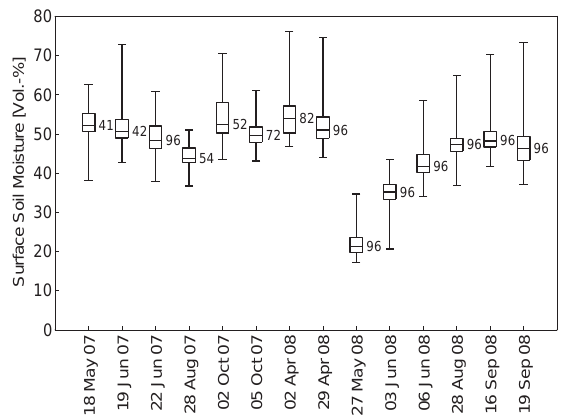
Figure 2. Box-Whisker-Plot for the grassland site of all days of surface soil moisture Fig. 2. Box-Whisker-Plot for the grassland site of all days of surface measurements; the bottom and top of the box show the lower and upper quartiles, the band soil moisture measurements; the bottom and top of the box show the near the middle of the box is the median, the ends of the whiskers represent the measured lower and upper quartiles, the band near the middle of the box is the minimum and maximum surface soil moisture; the number to the right of each box indicates median, the ends of the whiskers represent the measured minimum the number of sampling locations for each date; data sets without gaps (n = 96) were used for and maximum surface soil moisture; the number to the right of each the EOF analysis. box indicates the number of sampling locations for each date; data sets without gaps ( n =96) were used for the EOF analysis.